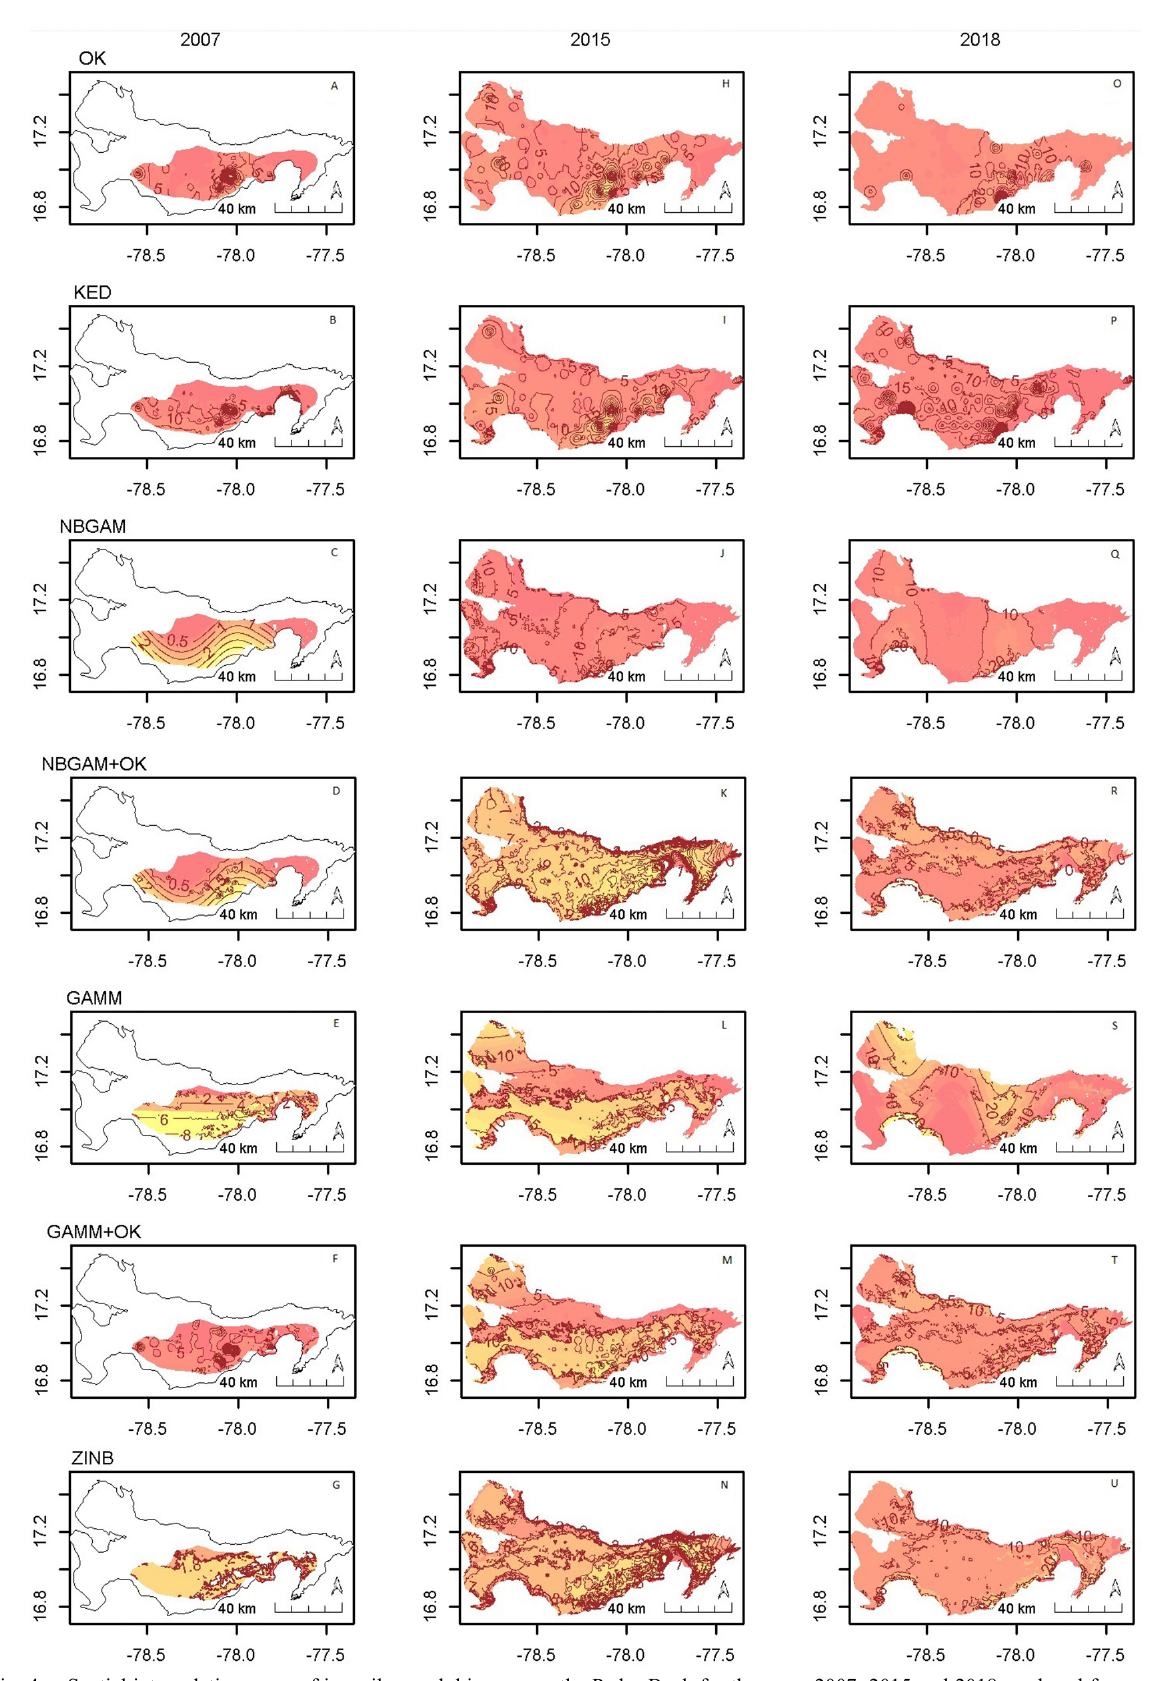
Fig. 4. – Spatial interpolation maps of juvenile conch biomass on the Pedro Bank for the years 2007, 2015 and 2018 produced from seven models: OK, KED, NBGAM, NBGAM+OK, GAMM, GAMM+OK and